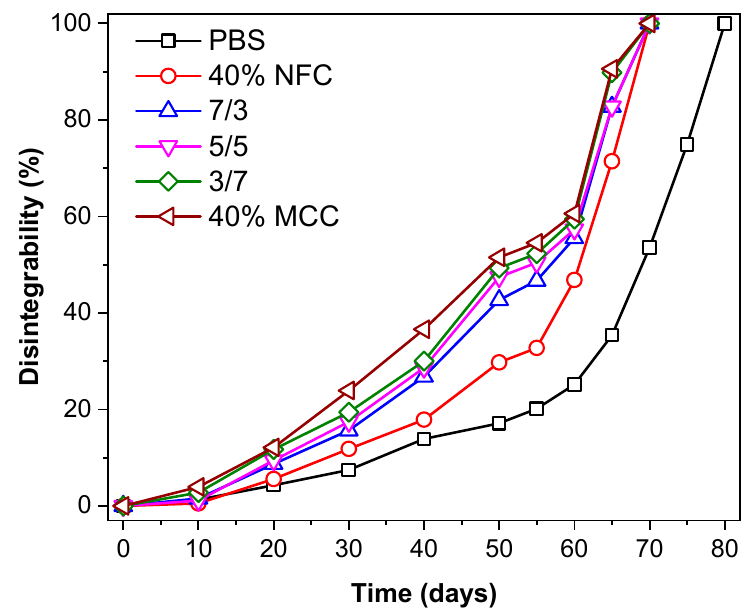
Figure 7. Percentage weight loss of PBS and PBS/cellulose composites in soil burial test conducted in composting conditions.